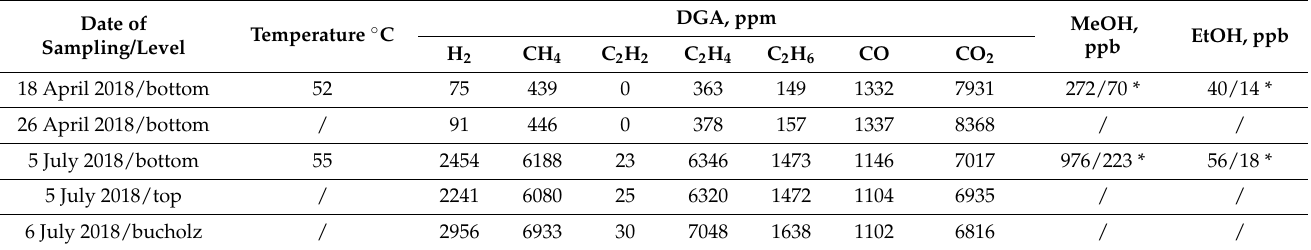
Table 9. Case 2. Results of dissolved gas analysis and methanol and ethanol before (18 April 2018,